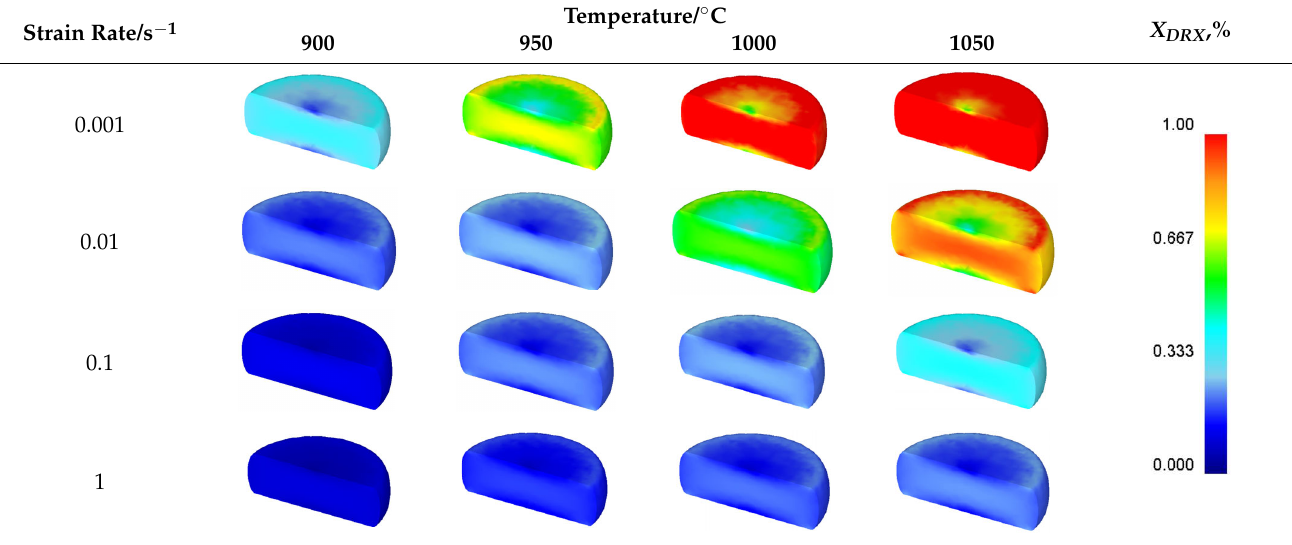
Table 3. The distribution of DRX X true strain of 0.7.